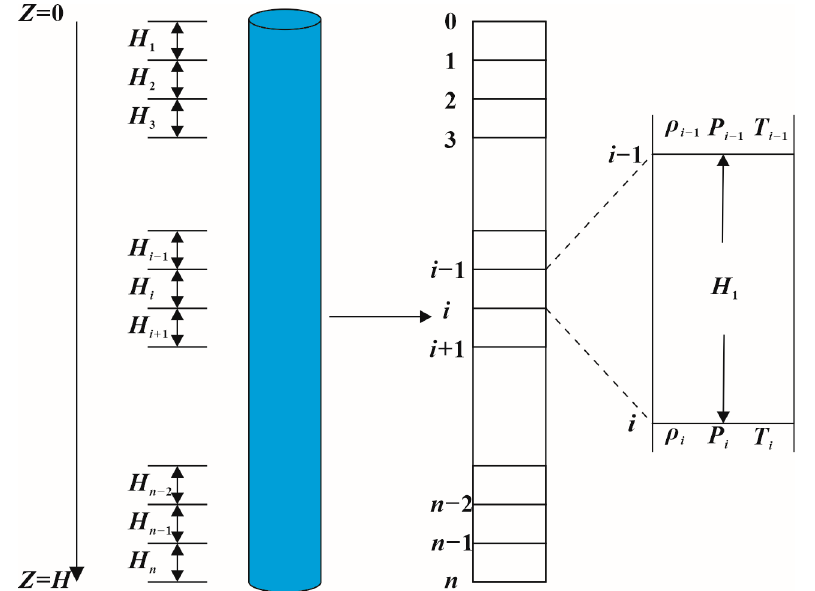
Figure 2. Detailed section map of the